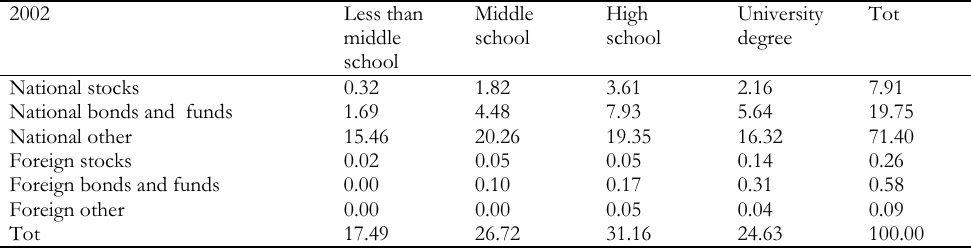
Italian households financial wealth by education of the head of the household, 2002 , percentages 2002 National